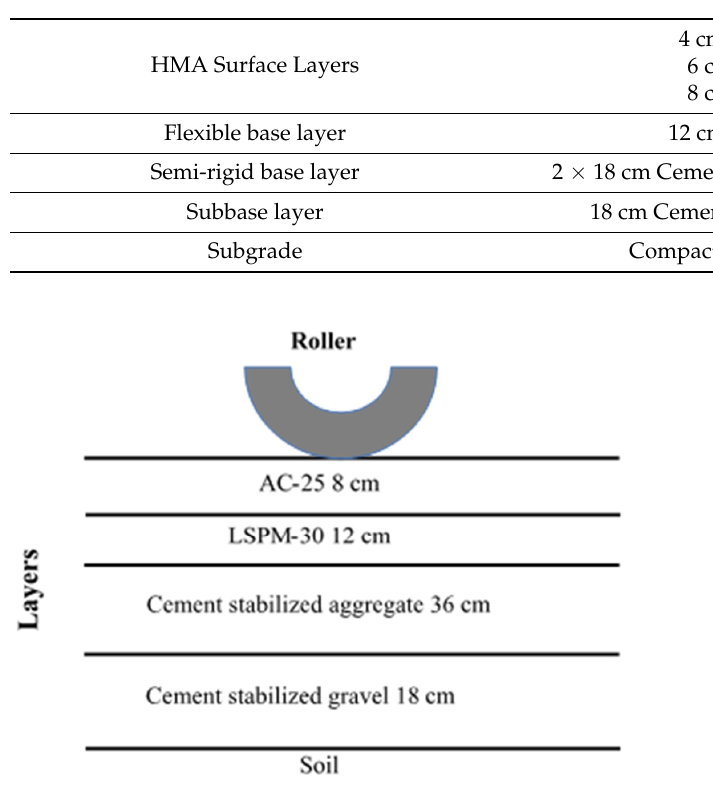
Table 1. Pavement structure in the project.